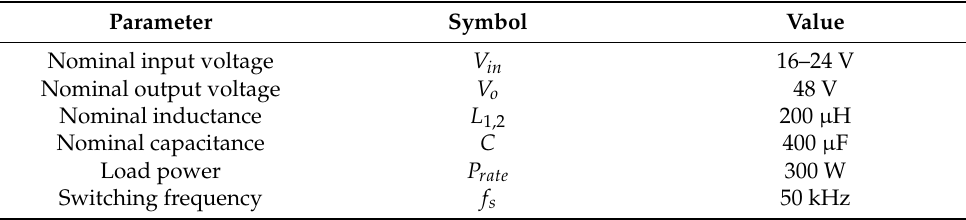
Figure 3. Snapshot and block diagram of the simulation: ( a ) simulation of TIBC under MATLAB/Simulink; ( b ) block diagram of simulation. Table 1. Detailed parameters of the converter.